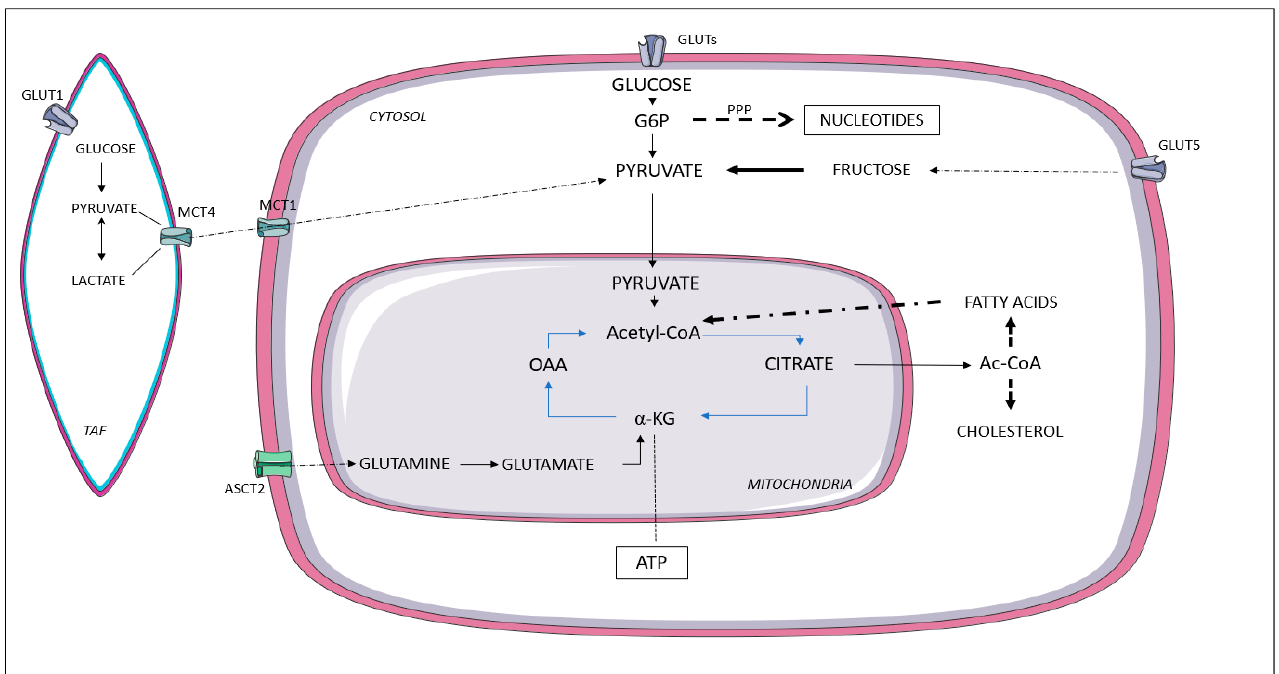
Figure 2. Overview of prostate cancer cell metabolism and its crosstalk with stromal components . TAF: tumor-associated fibroblast; MCT4: monocarboxylate transporter 4; MCT1: monocarboxylate transporter 1; GLUT: glucose transporter; G6P: glucose 6-phosphate; PPP: pentose phosphate path-